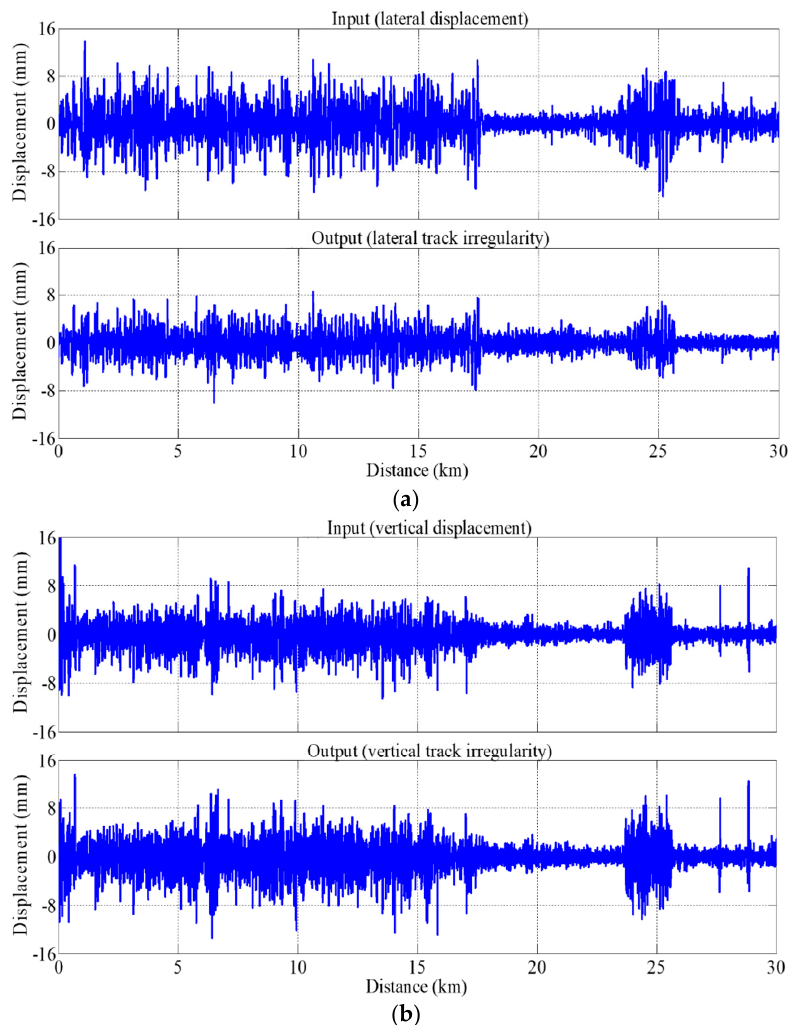
Figure 4. Input (displacement) and output (irregularity) signals for system identification: ( a ) lateral direction; ( b ) vertical direction.